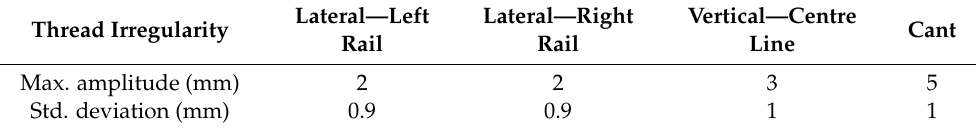
Table 4. Track irregularities.